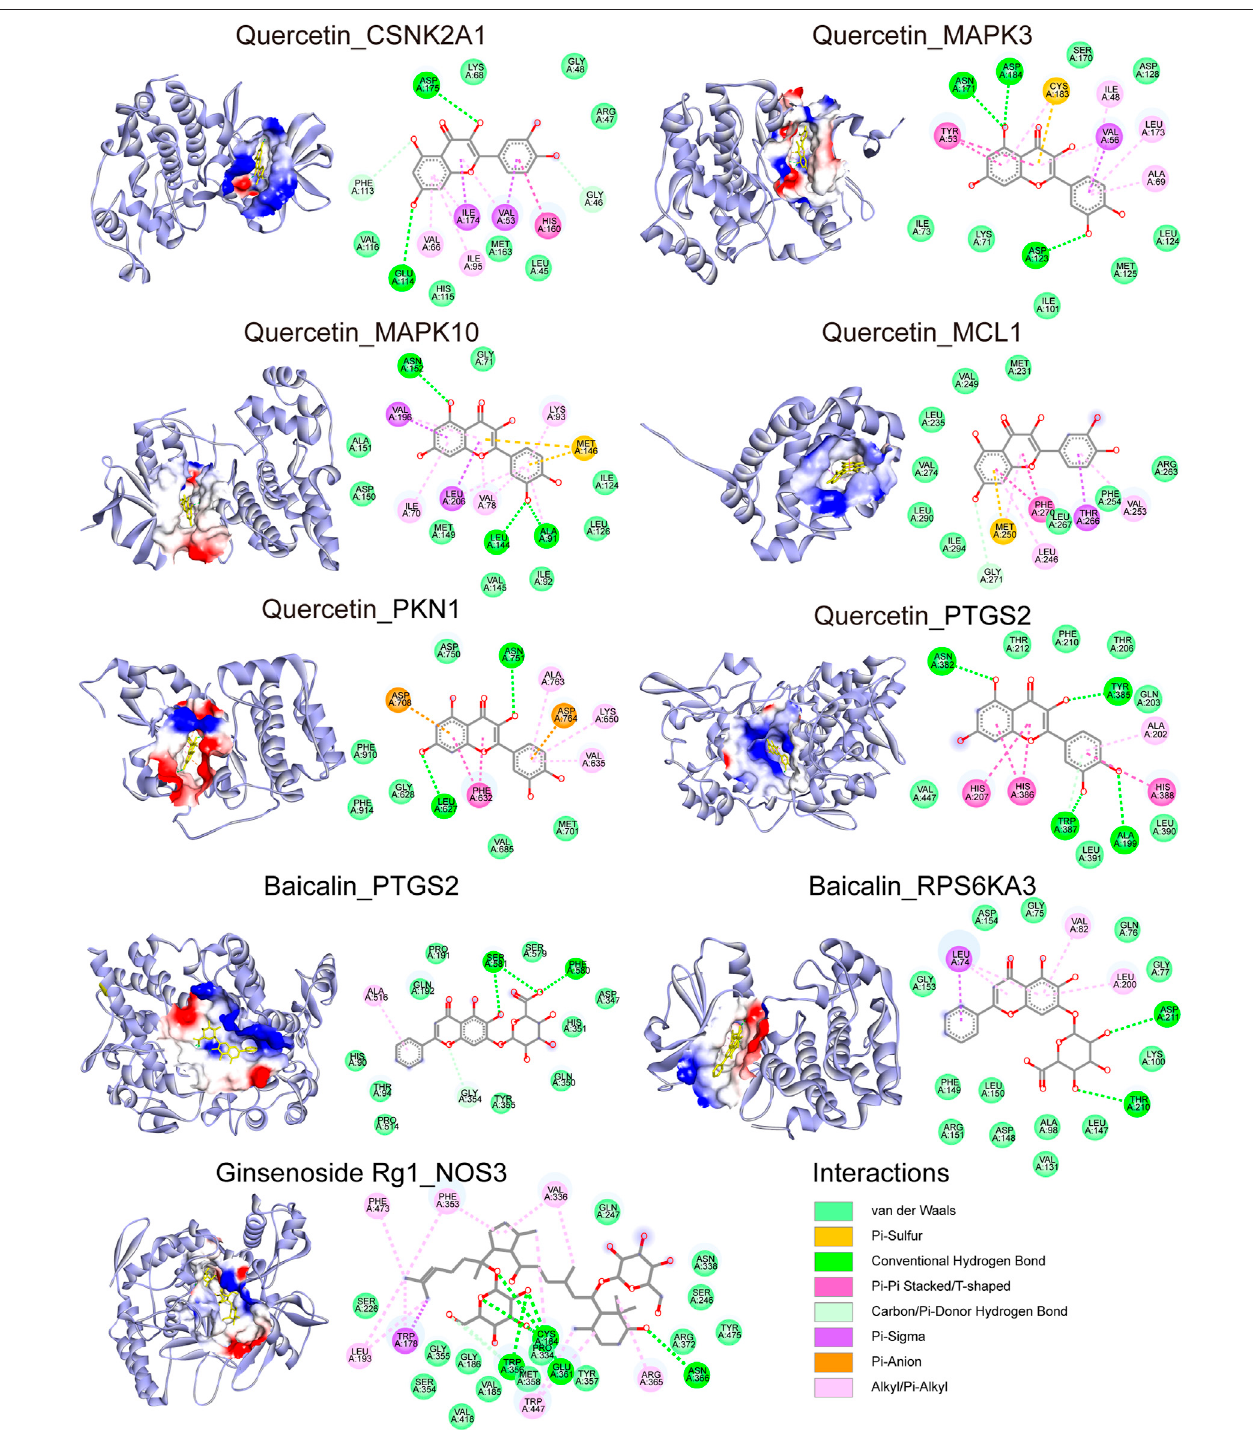
FIGURE 8 | Potential binding mode of the compound and the docking target: The structure of the protein and the docking site of the compound. The bonds between the compounds and the amino acid residues are indicated by colored dashed lines.